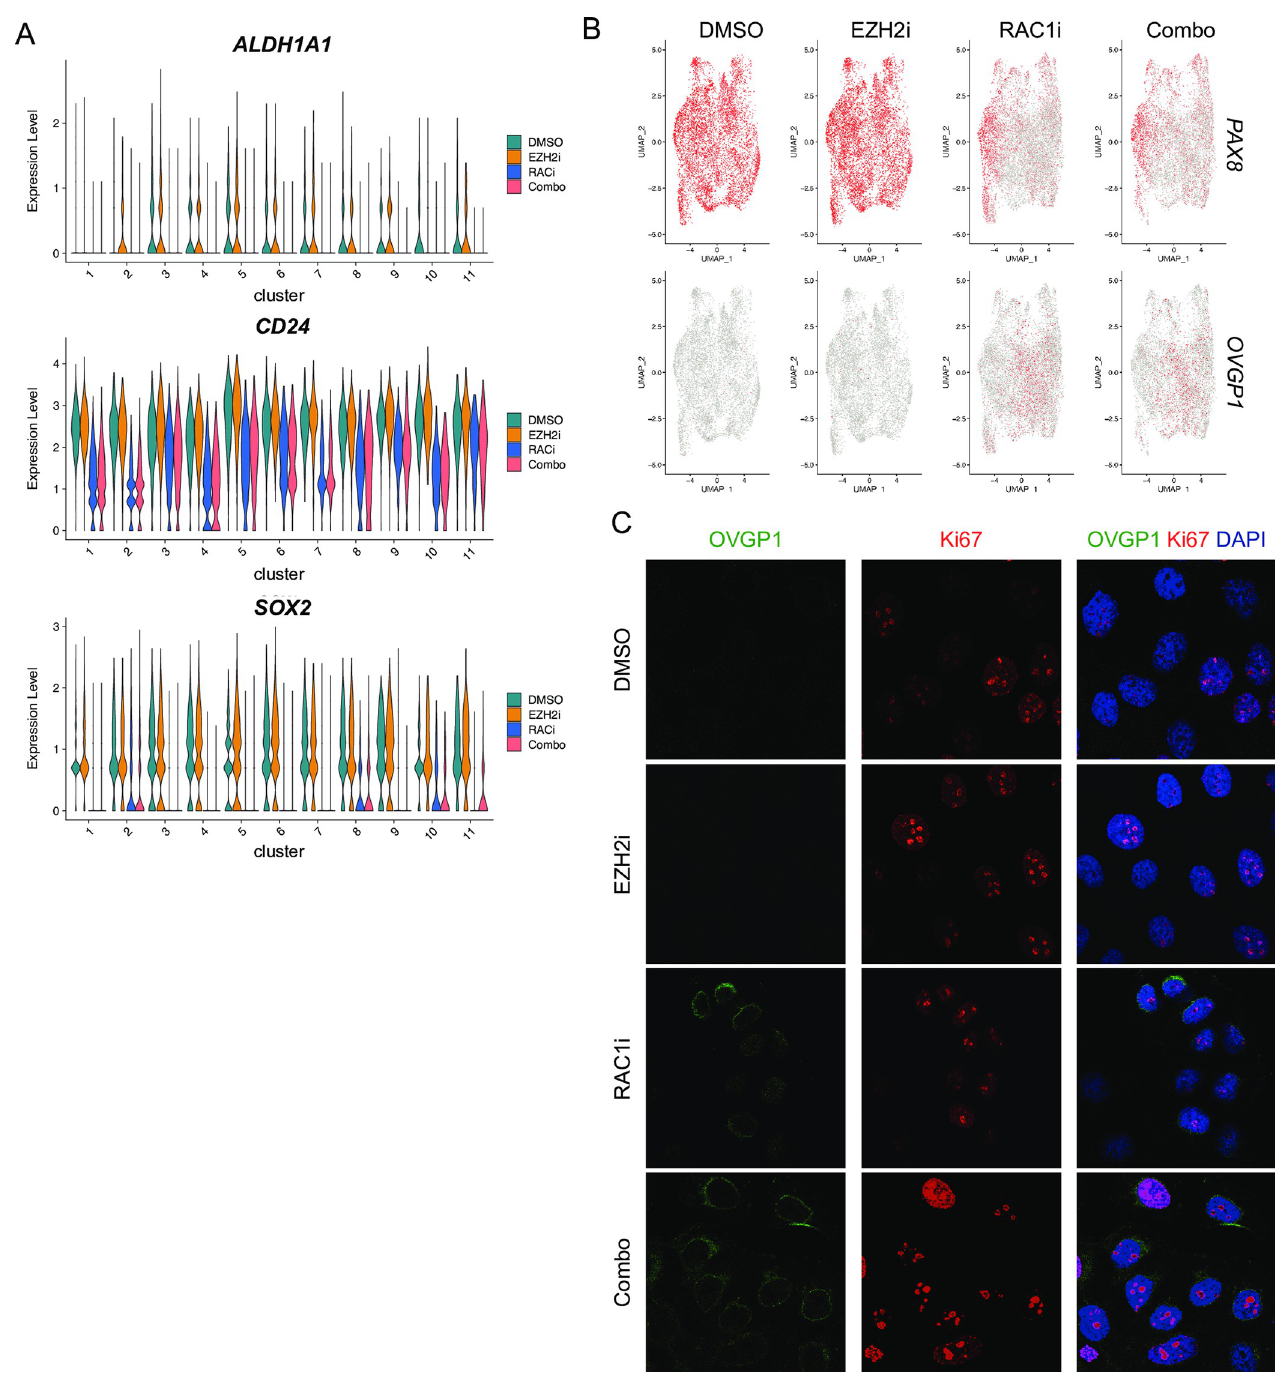
Fig 5. RAC1 inhibition reduces stem cell marker expression in most clusters. (A) Violin plots of expression levels of indicated genes in the different clusters and sample types. (B) UMAP dot plots of normalized gene expression values in the indicated sample types. (C) Representative immunofluorescence images of OVGP1 (green) and Ki67 (red) staining after DMSO, EZH2i (5 μ M, 48H), RAC1i (50 μ M, 48H), or Combo (RAC1i + EZH2i) treatment. N =